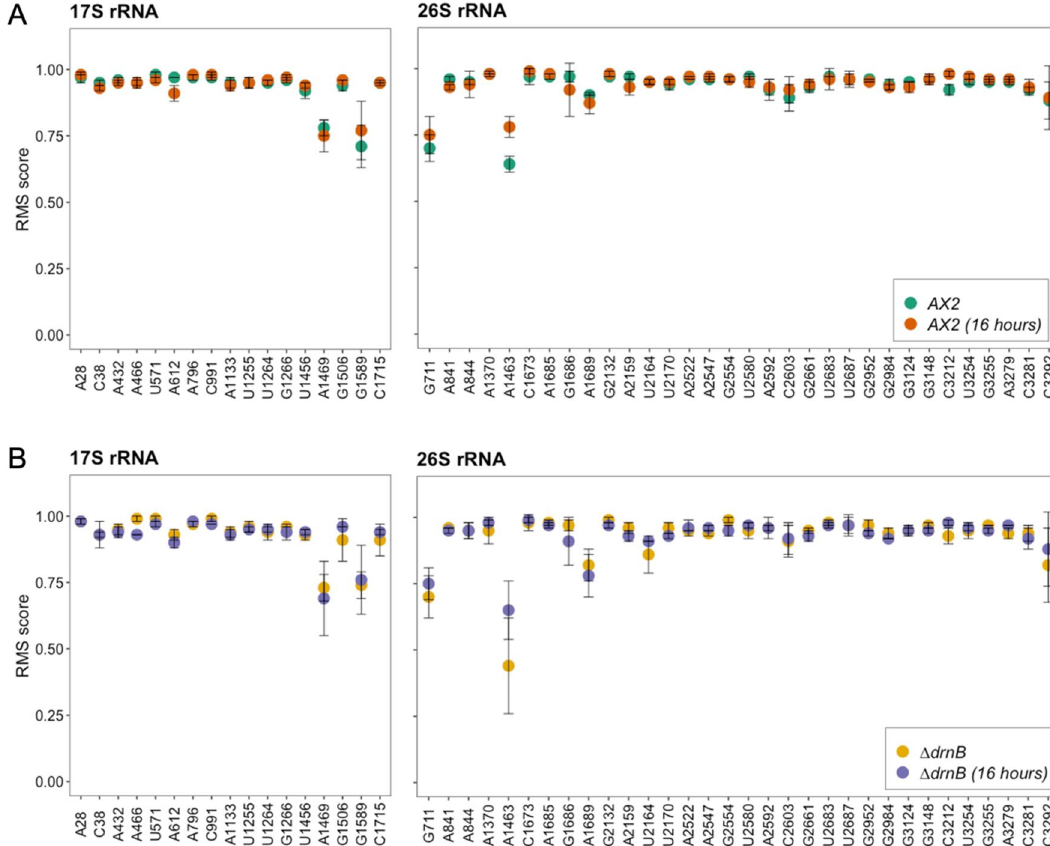
Figure 2. RiboMeth-seq analysis of the 17S and 26S in D. discoideum . RMS scores at 2 ′ - O -Me sites on the 17S and 26S rRNA in axenic growth and development of AX2 ( A ) and ∆drnB ( B ) cells (n = sequences of species from the evolutionary supergroups of Opisthokonta and Archaeplastida[31]. In brief, we aligned the rRNAs from the amoeba with the corresponding small and large subunits’ (SSU and LSU, respec- tively) rRNA sequences from A. thaliana, Caenorhabditis elegans, Drosophila melanogaster, and H. sapiens (Supplementary Table S3). The inferred secondary structure models of the 17S and 26S (with the 5.8S) rRNAs of D. discoideum are shown in Figs. 3 and 4, respectively, and include the 2 ′ -O-methylated positions. Central parts of ribosomes from different species are structurally highly conserved and variation appears restricted to peripheral regions and the so-called expansion segments (ES) 72 , which often harbor species-specific sequences. This is exactly what the models for the amoebal rRNA structures display (Figs. 3 and 4). This holds particularly true for the conserved regions involved in the formation of A, P and E sites. Not surprisingly, the ES of D. discoideum , which are not covered in the aforementioned structure 71 , exhibited significant differences as compared to the ES in other species (exemplified for H. sapiens ; Supplementary Table S6). About half of the 2 ′ -O methylated positions were found in the vicinity of nucleotides residing in the A, P and